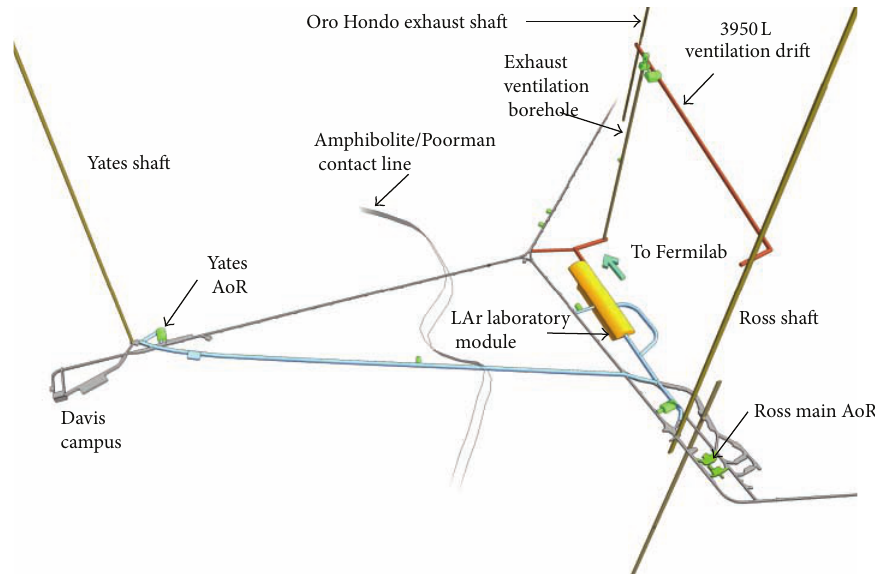
Figure 4: Location of LAr-FD at the 4850 L. Primary access to the upper level of the LAr-FD cavern is through a horizontal tunnel that connects to the Ross shaft. A second horizontal tunnel near the midpoint of the cavern provides secondary egress to the existing 4850 L tunnels. A decline tunnel to the lower level is used to remove waste rock during construction and serves as a secondary egress from the cryostat septum area during operations. Cavern supply air enters the cavern from the Ross shaft and exits through a new ventilation shaft that connects to the Oro